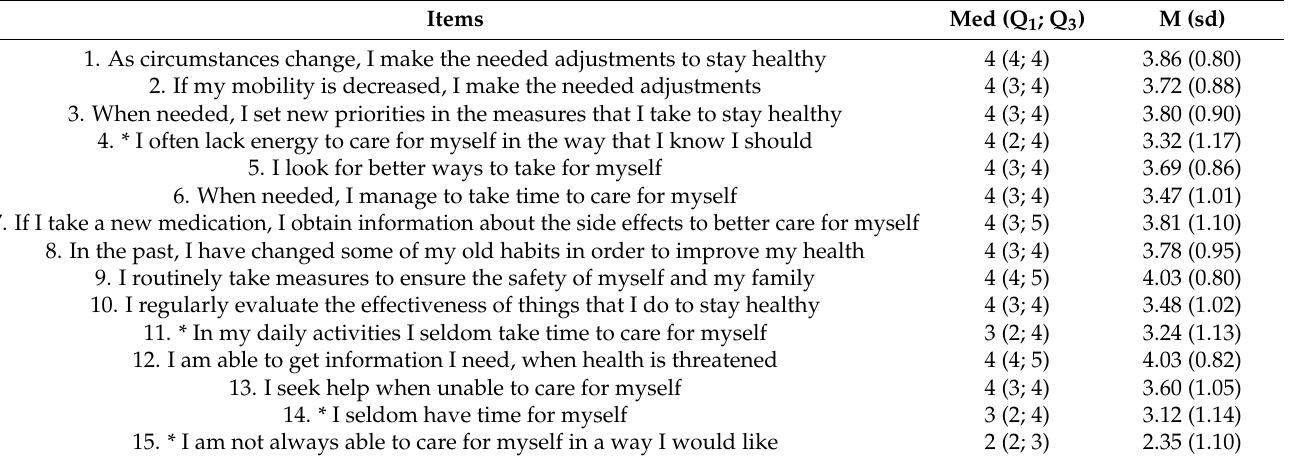
Table 2. 15-item ASAS-R’s descriptive statistics ( n =